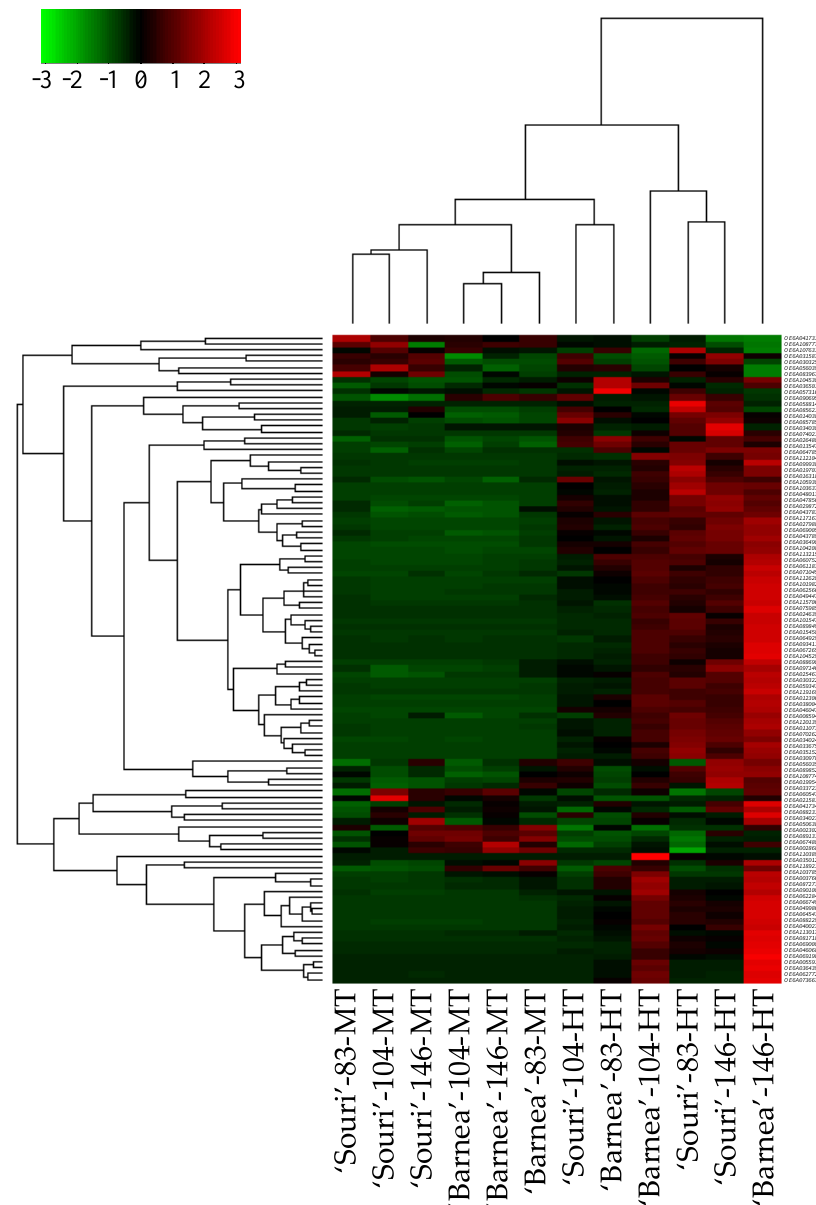
Figure 1. Hierarchical clustering of all heat-shock protein genes. Genes (rows) and samples (columns) were clustered according to their expression pattern. Sample names below include the cultivar-sample DPA-environment. Expression levels are indicated on an abundance scale of green to